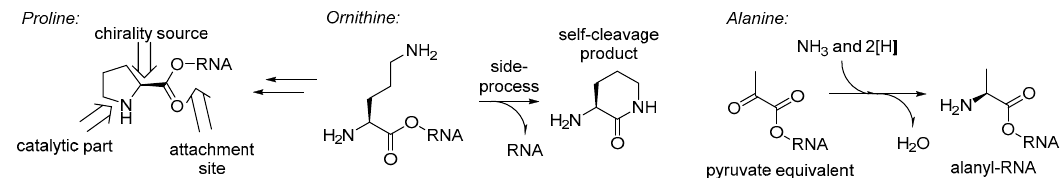
Figure 7. Chemical justification for the aminoacyl-RNA appearance in the GC-phase of the genetic code formation. code